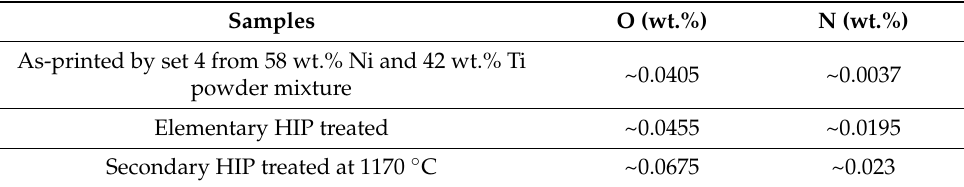
Table 6. Amounts of N and O impurities existing in the compositions of samples at different stages of as-printed, elementary HIP-treated, and secondary HIP-treated. These samples were processed from parts printed by set 4, having an energy input of 39.68 J/mm 3 , using the 58 wt.% Ni and 42 wt.% Ti powder mixture. Samples O (wt.%) N (wt.%) As-printed by set 4 from 58 wt.% Ni and 42 wt.% Ti ~0.0405 ~0.0037 powder mixture Elementary HIP treated ~0.0455 ~0.0195 Secondary HIP treated at 1170 ◦ C ~0.0675